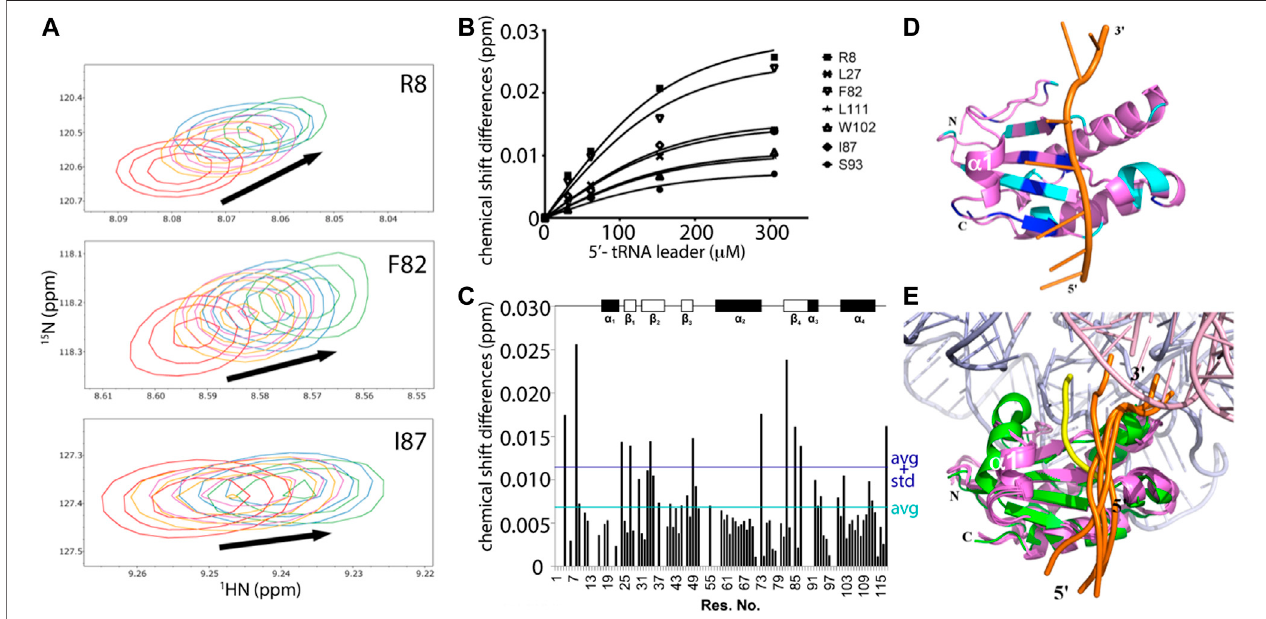
FIGURE 5 | NMR mapping and modeling of the P protein-5 ’ pre-tRNA leader interaction. (A) Representative chemical shift perturbations (CSP) corresponding to RNA titrations to a 153 μ M P protein sample. Overlay of 1 H, 15 N-HSQC spectra show the chemical shift changes due to RNA binding, where RNA-protein ratios are 0:1 (red), 0.2:1 (orange), 0.4:1 (purple), 1:1 (blue), and 2:1 (green). (B) Example curves included in global fi tting of deriving dissociation constant of T. maritima P protein-5 ’ leaderinteraction (K D (cid:1) 47.2 ± 14.0 μ M, R 2 (cid:1) 0.983). (C) CSP map ofligand-protein molarratioat 2:1, withindicatedchemicalshiftchanges( Δ δ ) ( y -axis)byresidue ( x -axis). The dark blue line represents one standard deviation above the average chemical shift difference ( Δ δ average + STD Δ δ ). The cyan line represents the average chemical shift difference ( Δ δ average). Schematic plot shows the P protein secondary structure (top). (D) The best scored HADDOCK model of the P protein-5 ’ leader interaction in solution. The lowest energy NMR-derived CS-ROSETTA model (violet) is depicted as ribbons (helix) and arrows ( β -sheets) and the 5 ’ leader RNA is shown asacartoon(orangebackbonetraceandgreen/bluenucleobases).Residueswithsigni fi cantCSP( Δδ ≥ Δ δ average +STD Δ δ )arehighlightedindarkblue,andresidueswith largeCSP( Δ δ average +STD Δ δ ≥ Δδ ≥ Δ δ average )arecoloredincyan.TheCS-RosettageneratedmodelderivedfrommonomericchemicalshiftdatawasusedinHADDOCK calculations to compare NMR-based data in solution to the available X-ray data (PDBs 1NZ0 and 3Q1R). (E) A structural overlay of the HADDOCK generated models (protein/5 ’ leader, colored as violet/orange) in the context of the bacterial RNase P holoenzyme crystal structure, which emphasizes the P protein-5 ’ leader interface, colored green/yellow, that is derived from electron density data (PDB 3Q1R). 4 HADDOCK models with the lowest energies were superposed with PDB 3Q1R. The RNase P RNA and tRNA are colored light blue and pink, respectively, and the 5 ’ and 3 ’ ends of the leader RNAs are